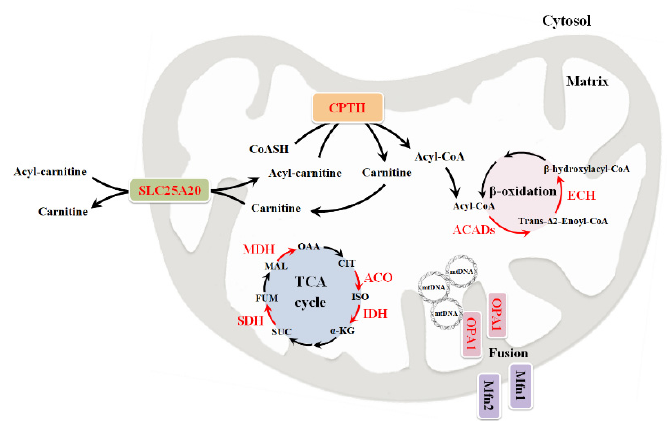
Figure 2. Schematic representation of altered mitochondrial enzymes in NMDs. Mitochondrial metabolic pathways involved in NMDs are shown, and mutated enzymes are highlighted in red. For details, see the text. α -KG, α -ketoglutarate; ACAD, acyl-CoA dehydrogenase; ACO, aconitase; ASP, aspartate; CIT, citrate; CoASH, coenzyme A; ECH, 2-enoyl-CoA hydratase; FUM, fumarate; IDH, isocitrate dehydrogenase; ISO, isocitrate; MAL, malate; MDH, malate dehydrogenase; Mfn1/2, mitofusins 1 and 2; OAA, oxaloacetate; OPA1, optic atrophy 1 protein; SDH, succinate dehydrogenase; SUC, succinate; TCA, tricarboxylic acid cycle.